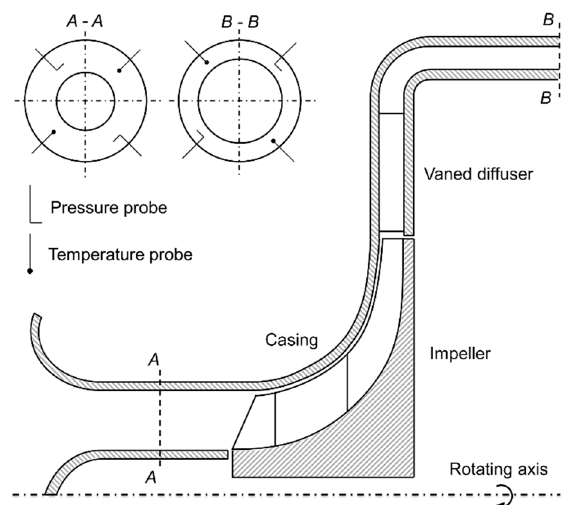
Figure 6. Schematic of compressor test sections.